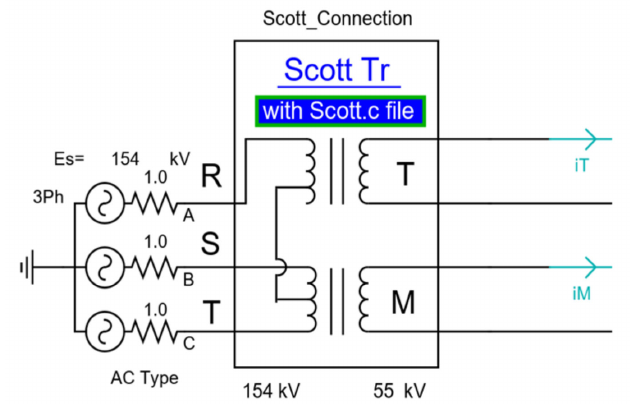
Figure 7. The proposed Scott transformer model linked to C source code in RSCAD.